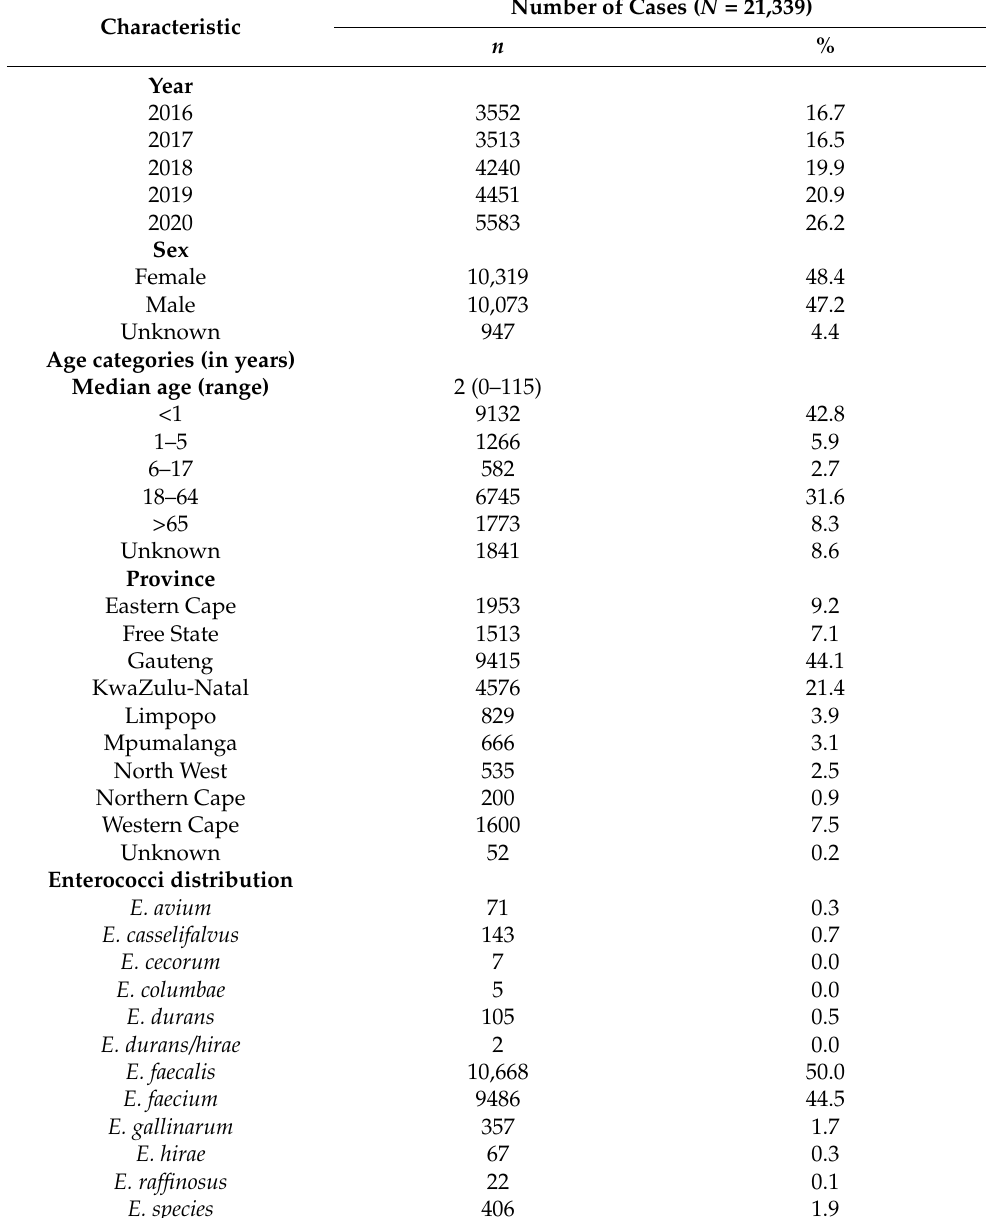
Table 1. Demographic characteristics of cases with enterococci isolated from blood cultures in South Africa from 2016 to 2020 ( n =